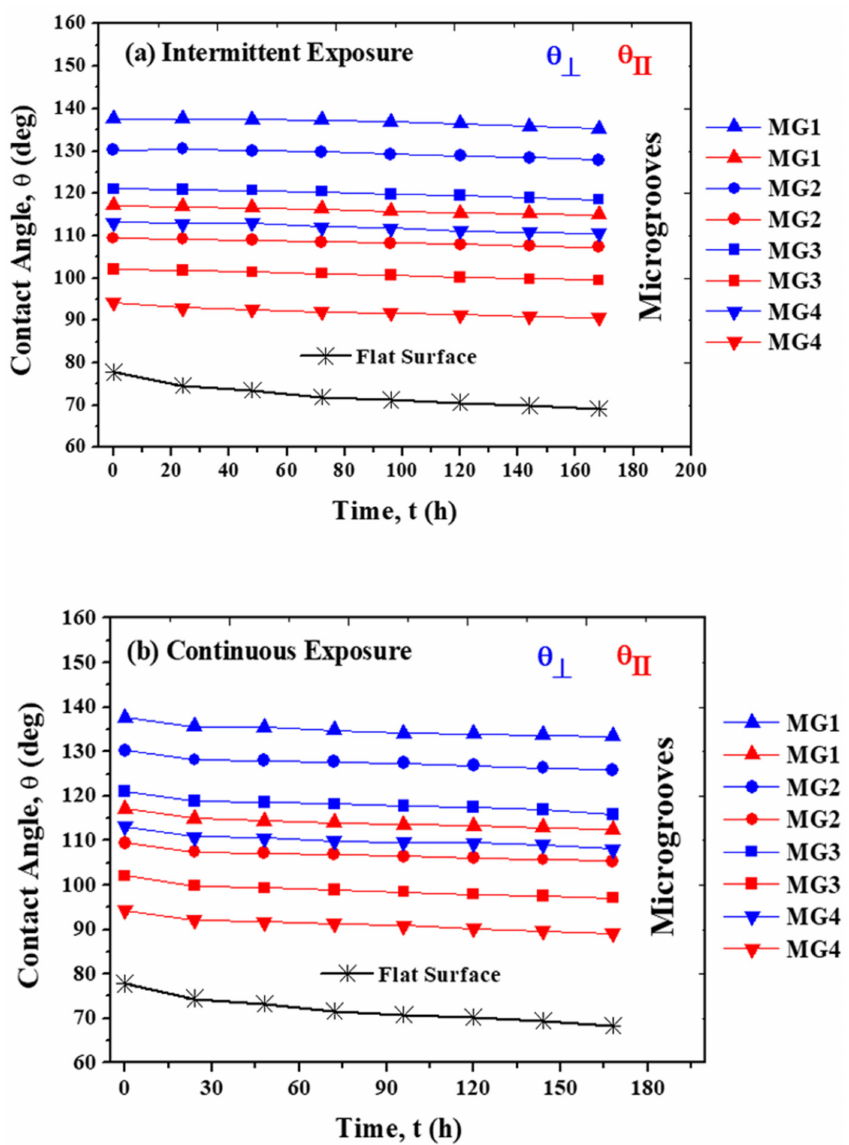
Figure 5. Contact angles of the surfaces measured ( a ) before (0 h), during and after intermittent exposure and ( b ) before (0 h), during and after continuous exposure to 3.5 wt. % NaCl solution for 168 h as a function of exposure time